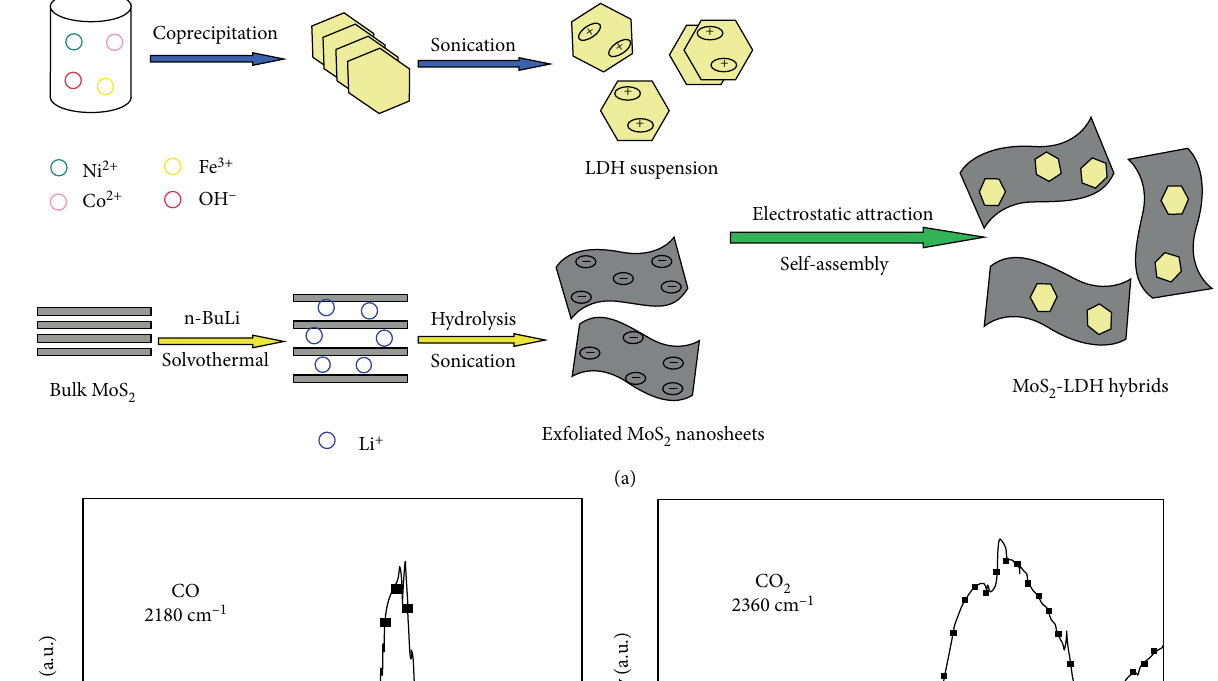
-LDH nanohybrids via a self-assembly method. (b) Intensity of characteristic peaks for 2 composites. (c) The TSP and THR of EP and EP composites. Adapted from 2